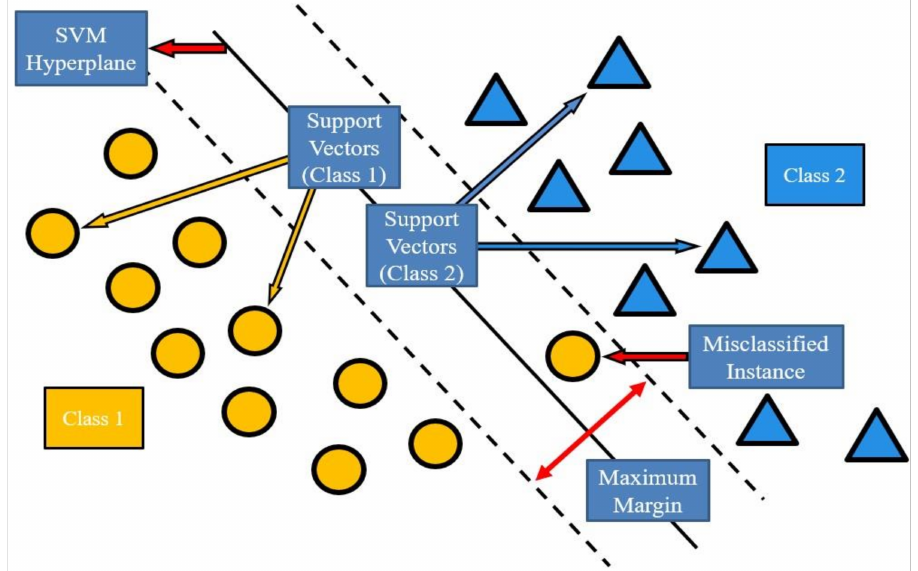
Figure 1. Schematic diagram of